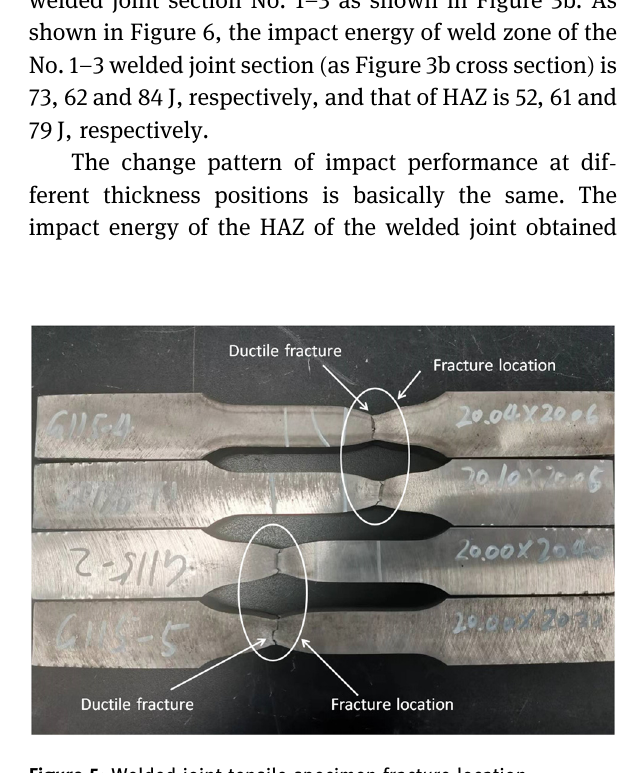
Figure 5: Welded joint tensile specimen fracture location.